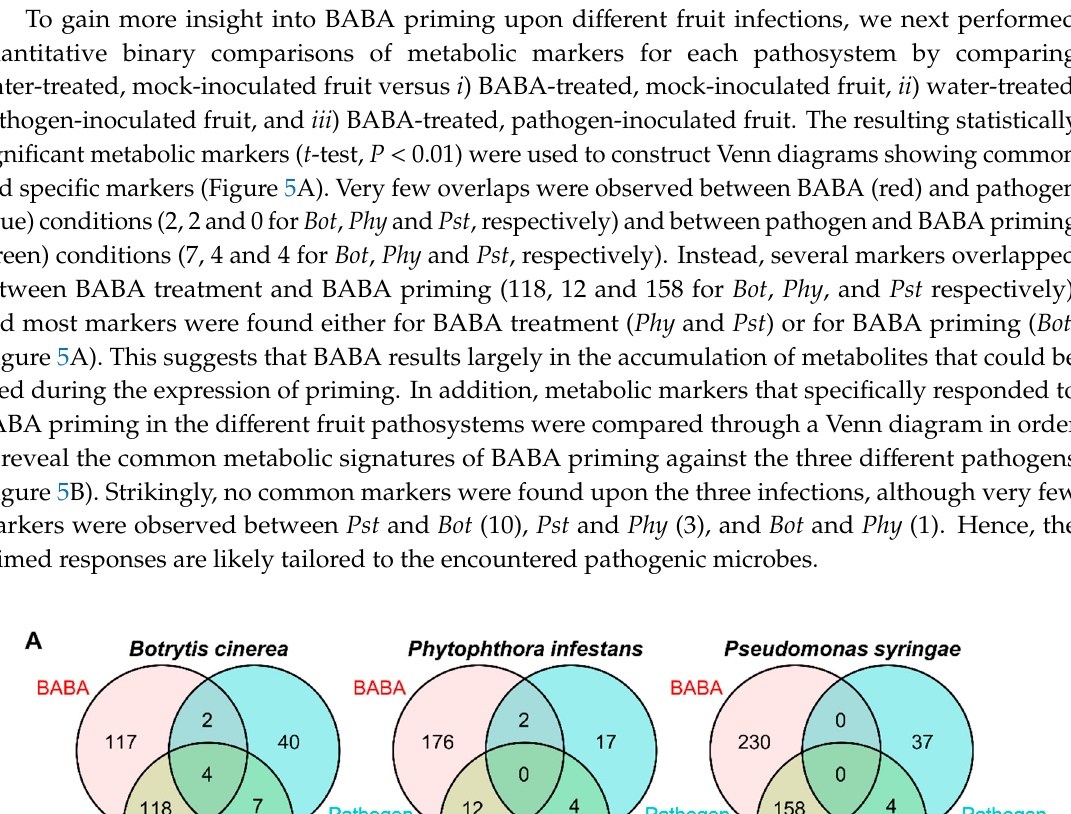
Figure 4. Partial segregation of pathogen inoculations for each fruit pathosystem. PCA score plots ( n = 4) of 6898 features (6887 electrospray ionisation orbitrap high-resolution mass spectrometry (LCMS) variables + 11 major compounds) showing metabolomics overview between the three different pathosystems. Maximal variance explained by each PC are given in brackets.